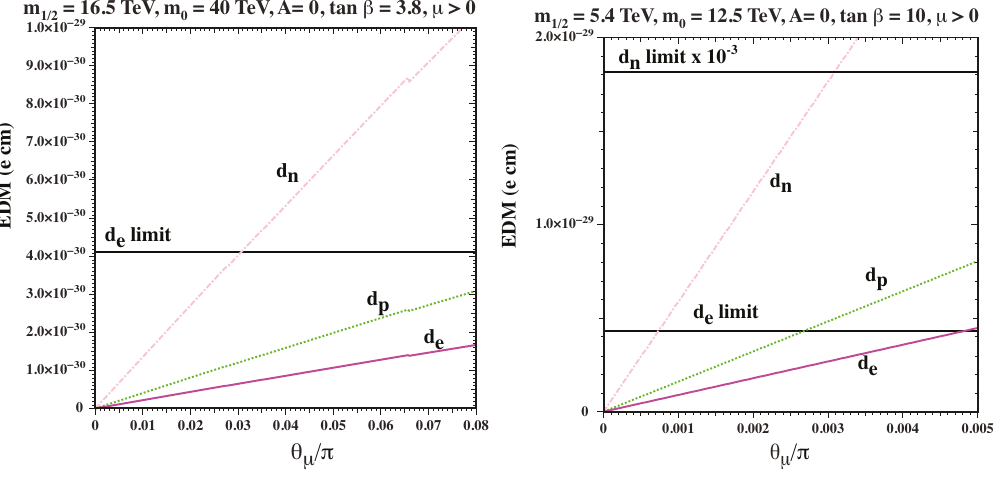
Figure 5 . e , p , and n EDMs as a function of θ µ for fixed m 1